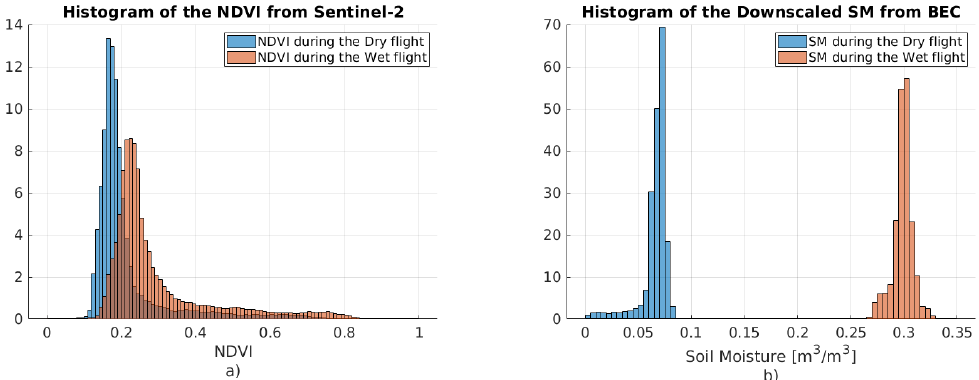
Figure 5. Histograms of the collocated Sentinel-2 NDVI ( a ) and downscaled SM ( b ) values over the MIR specular points for both the Dry and Wet